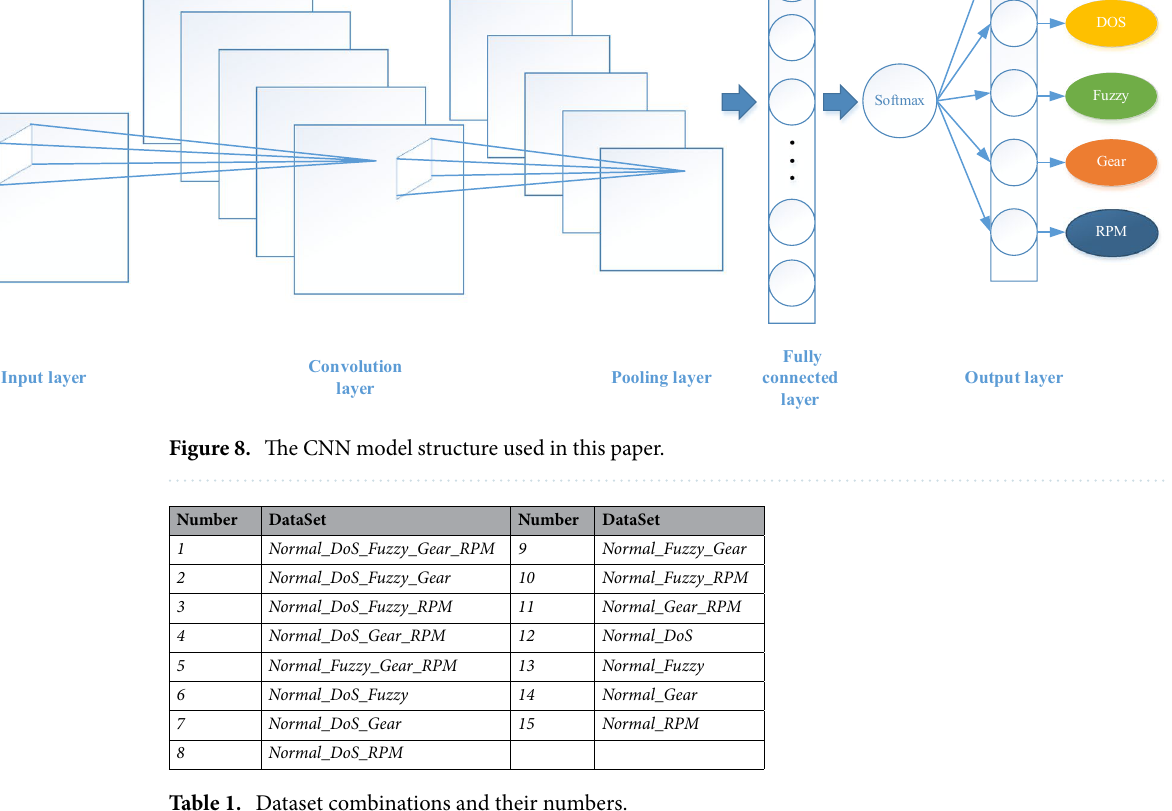
Table 1. Dataset combinations and their